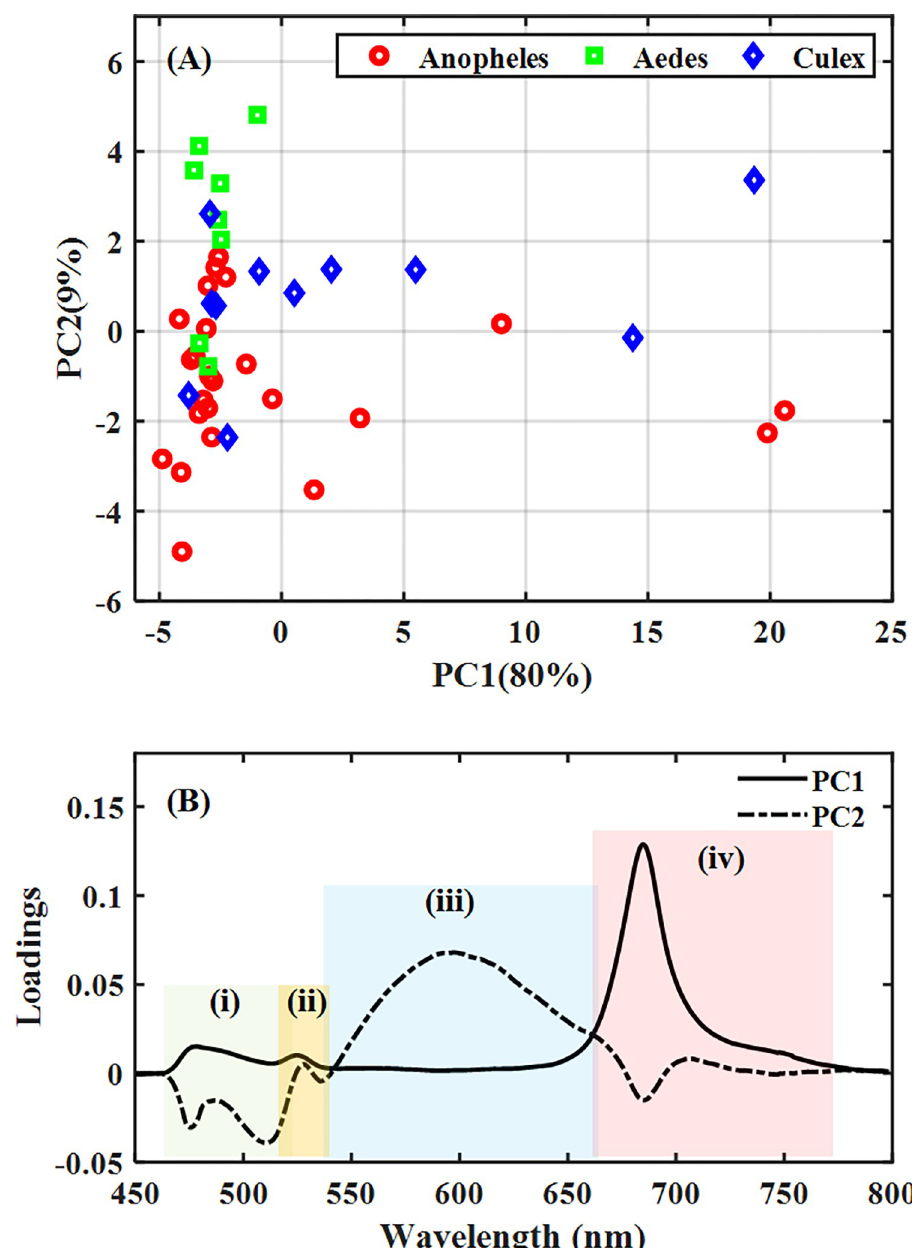
Fig 6. PCA of LIF spectra of water samples from the various breeding sites with (A) Score plot showing distribution pattern among samples and (B) loading plot for PCs 1 and 2 showing specific regions (wavelengths) causing the distribution pattern in the score plot; (i) 460 nm– 515 nm, and (iii) 535 nm– 660 nm representing the DOM region, (ii) 515 nm– 535 nm representing the water Raman band and (iv) 660 nm– 780 nm representing the Chlorophyll region.